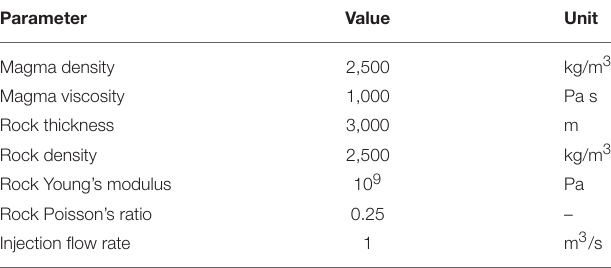
TABLE 1 | Input parameters used for the simulation of the reference case